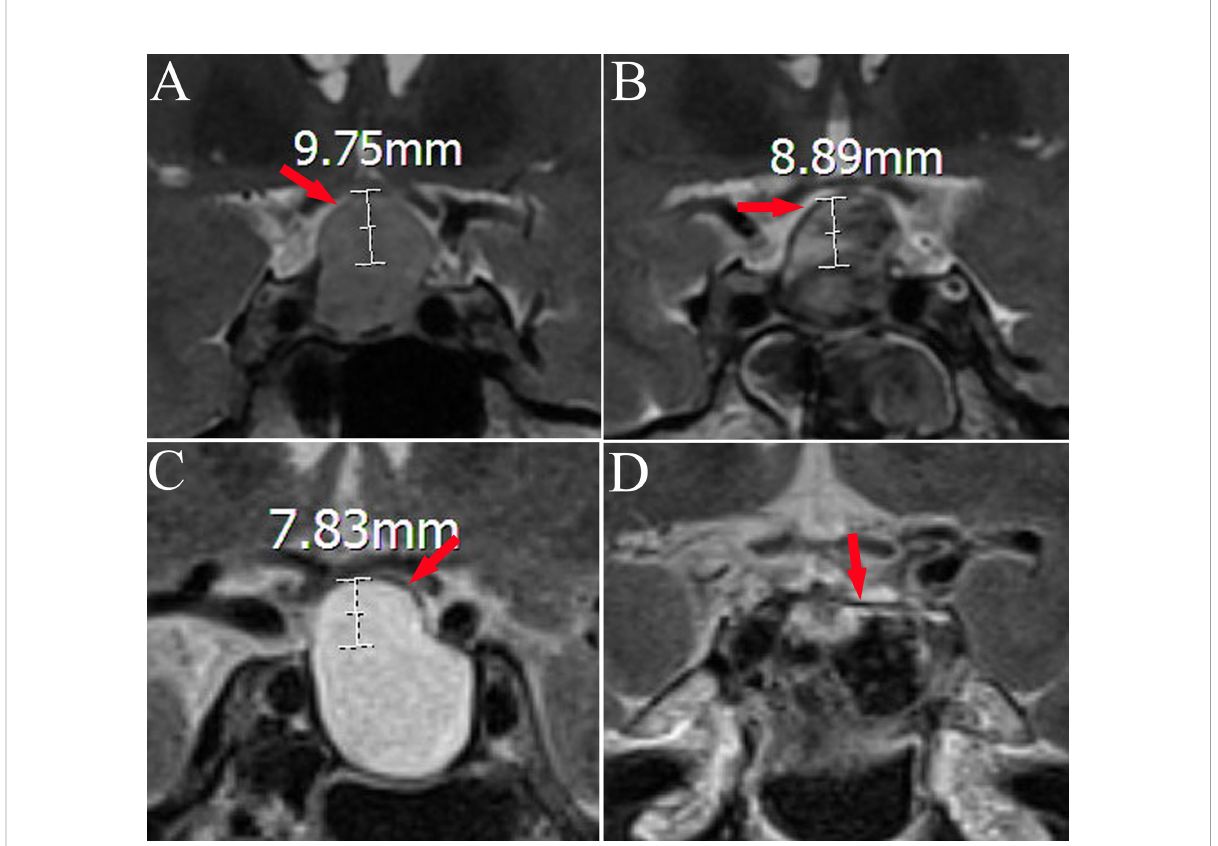
FIGURE 1 Magnetic resonance changes in the diaphragma sellae before and after transsphenoidal surgery in two cases. Panels A, B and panels C, D are from the same patient; diaphragma sellae (red arrow) (A) . Hypointense shadow of diaphragma sellae in preoperative T2-weighted imaging (diaphragma sellae height 9.75 mm). (B) The diaphragma sellae in postoperative T2-weighted imaging (diaphragma sellae height 8.89 mm). (C) Hypointense shadow of diaphragma sellae in preoperative T2-weighted imaging (diaphragma sellae height 7.83 mm). (D) The diaphragma sellae in postoperative T2-weighted imaging (diaphragma sellae height 0 mm).